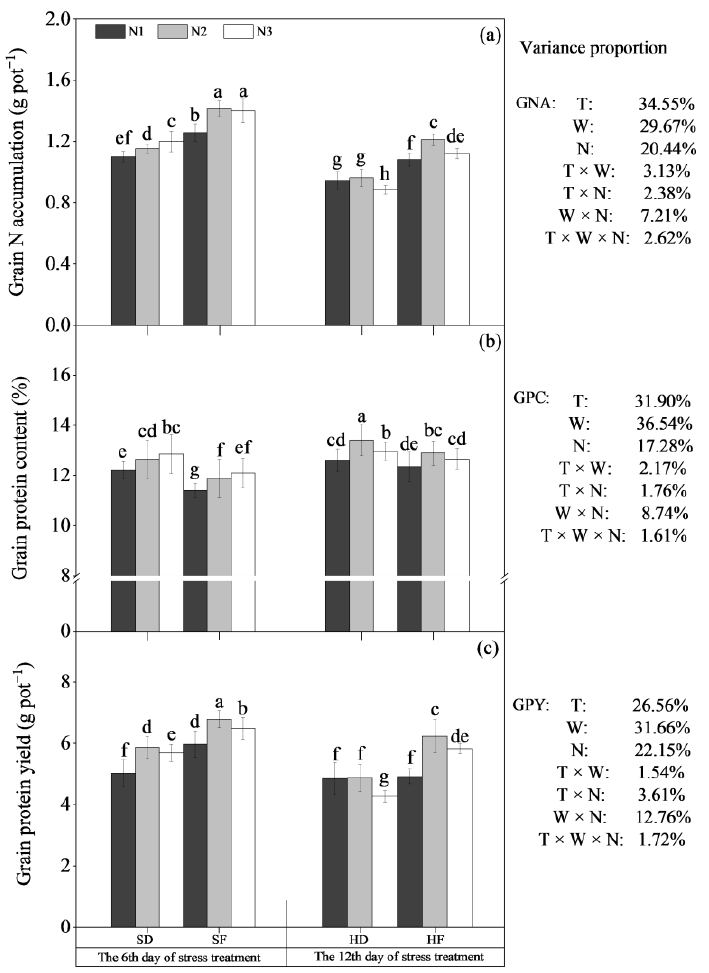
Figure 6. Effects of N application on grain N accumulation ( a ), grain protein content ( b ) and grain protein yield ( c ) under short-term heat, drought and combined stress after anthesis. SD: suitable temperature + drought stress; HD: heat + drought stress; HF: heat stress + full watering; SF: suitable temperature + full watering. T: temperature; W: watering; N: nitrogen. The values are the means ± standard deviation, n = 5. Different lowercase letters indicate statistically significant differences ( p < 0.05). The right side of the figure shows the proportion of variance explained by each factor and